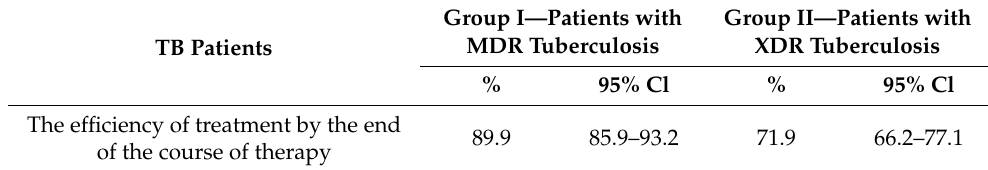
Table 4. Comparison of the results of MDR and XDR TB